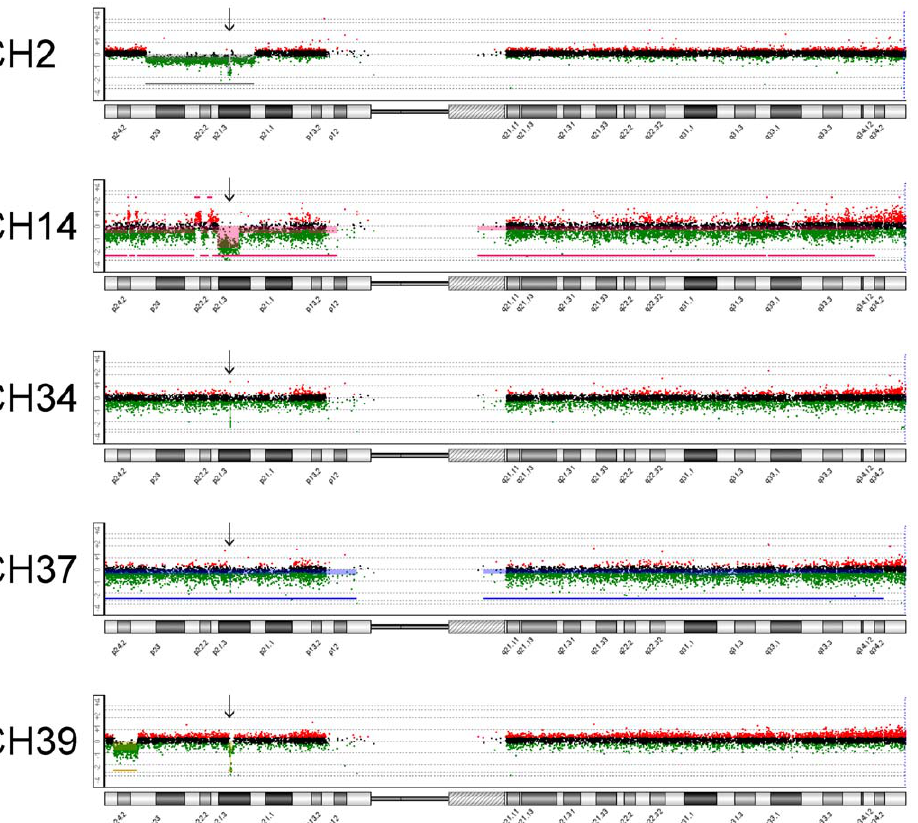
Figure 3. Chromosome 9 array CGH results. Array CGH results for chromosome 9 are shown for select chordoma cases showing homozygous CDKN2A deletion. Plots were generated with the Agilent Genomic Workbench Standard Edition 5.0 software. The sizes of the homozygous deletions for the five respective cases are as follows: 512 kb, 4.7 Mb, 76 kb, 76 kb, and 158 kb. Note that cases CH34 and CH37 are recurrent tumors from the same patient. Cases CH7 (158 kb) and CH36 (1.9 Mb) also harbor homozygous CDKN2A deletions and are not depicted above. kb=kilobases, Mb=megabases.